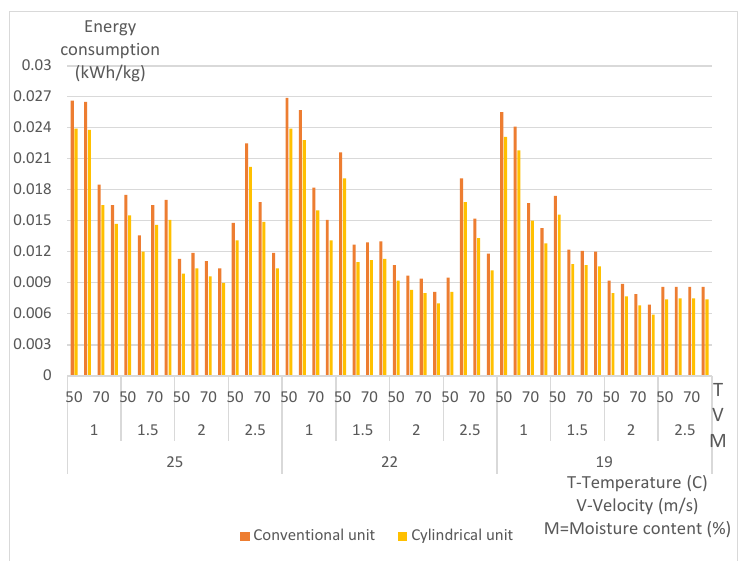
ergy consumption per unit mass was measured.